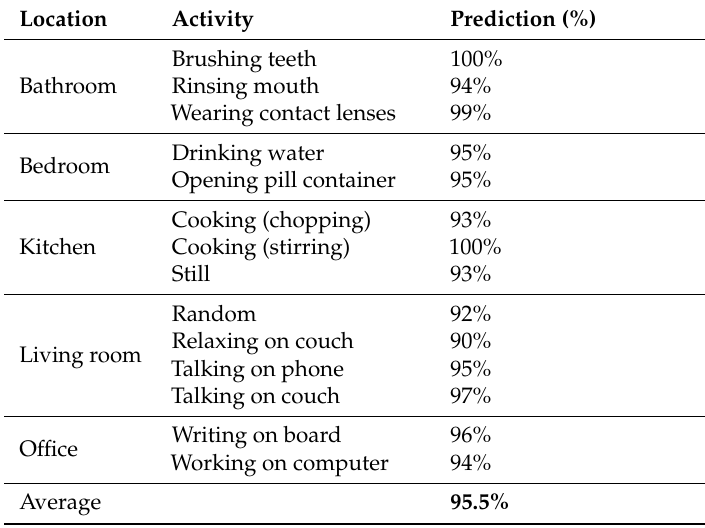
Table 3. Performance of our proposed system according to human locations using the CAD-60. Five locations are presented: bathroom, bedroom, kitchen, living room, and o ffi